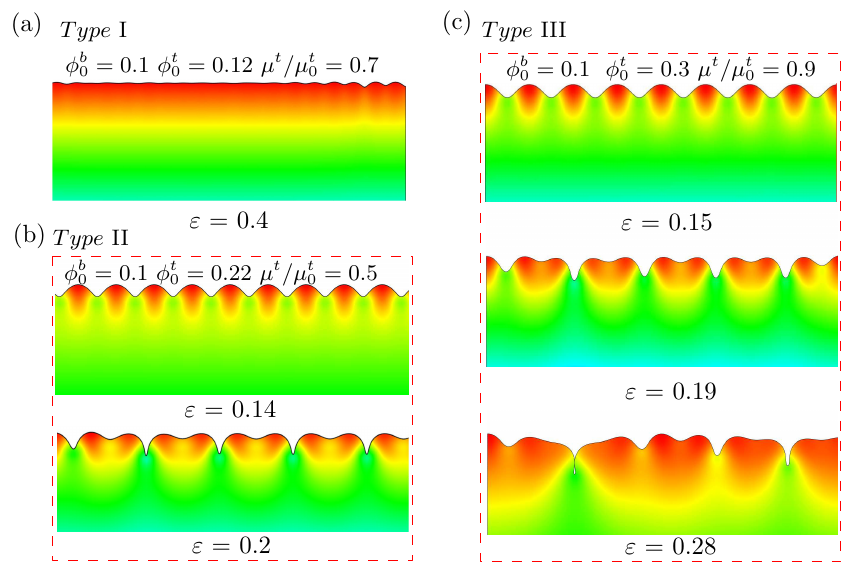
Figure 7. Surface morphologies of bilayer hydrogel modeled by the finite element (FE) simulations under different levels of compressive strain with the pre-absorption of water in the upper layer, when the initial volume fraction of polymer chain φ t varied and the lower layer was fixed as φ b 0 = 0.12, ( b ) φ t = 0.22, and ( c ) φ t = 0.3. These are typical surface instability patterns, named ( a ) φ t 0 0 0 types I, II, and III,